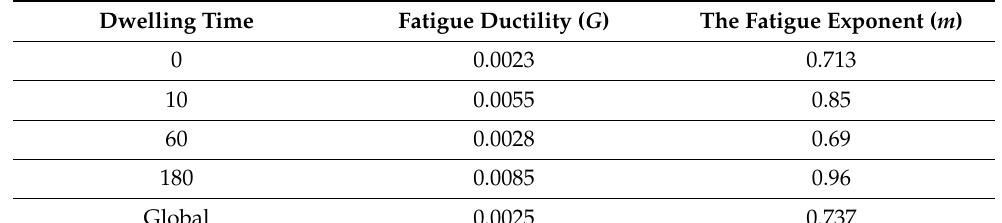
Figure 33. Characteristic life (global Morrow Energy equation) vs. plastic work for SAC305 joints at various dwelling times on a log–log scale.